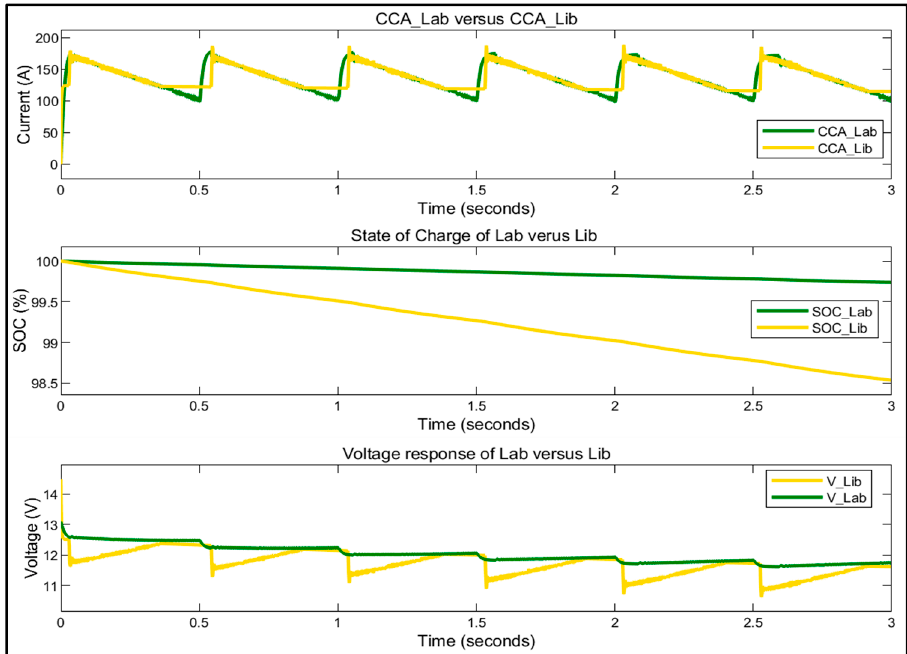
Figure 17. The percentage CCA, SoC , and voltage response of hybridized ESSs during discharge mode for case two.